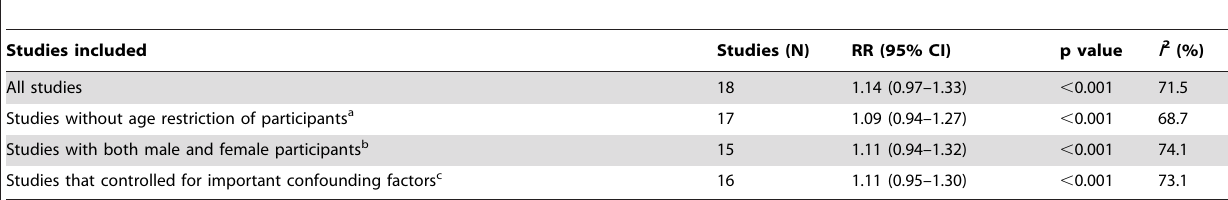
Table 3. Sensitivity analysis of the association between multiple myeloma and rheumatoid arthritis according to different exclusion